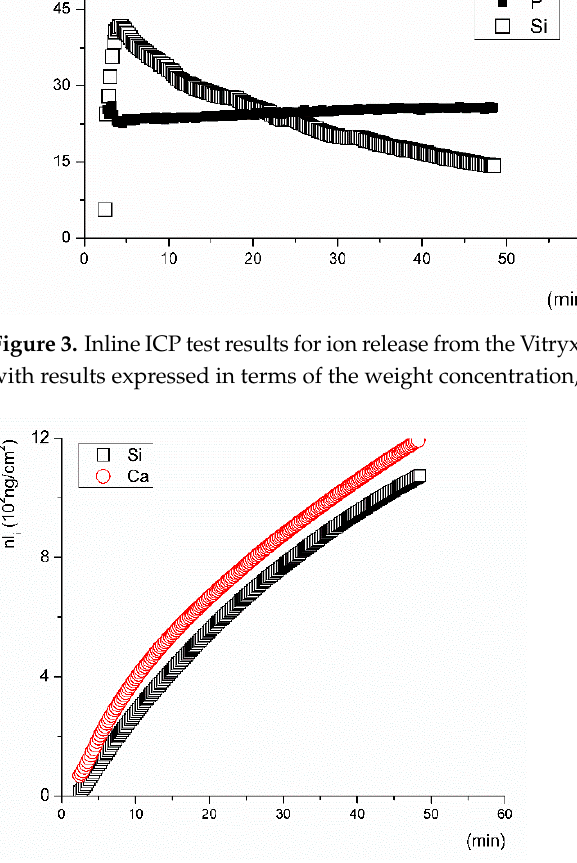
Figure 4. Inline ICP test results expressed as the cumulative converted ion (Si-squares and Ca-circles) amount from the VB glass in the SBF solution when normalized to its surface area (S).